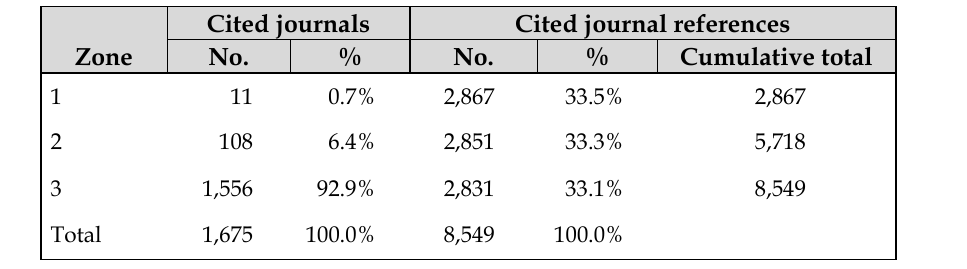
Table 3 Distribution by zone of cited journals and references